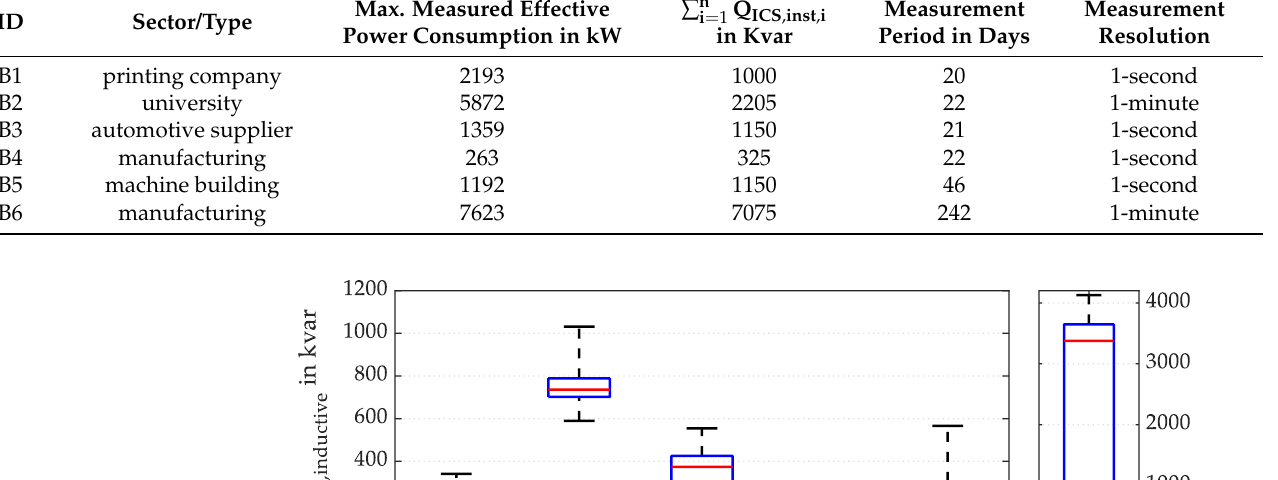
Table 2. Characteristic data of six measured industrial companies.